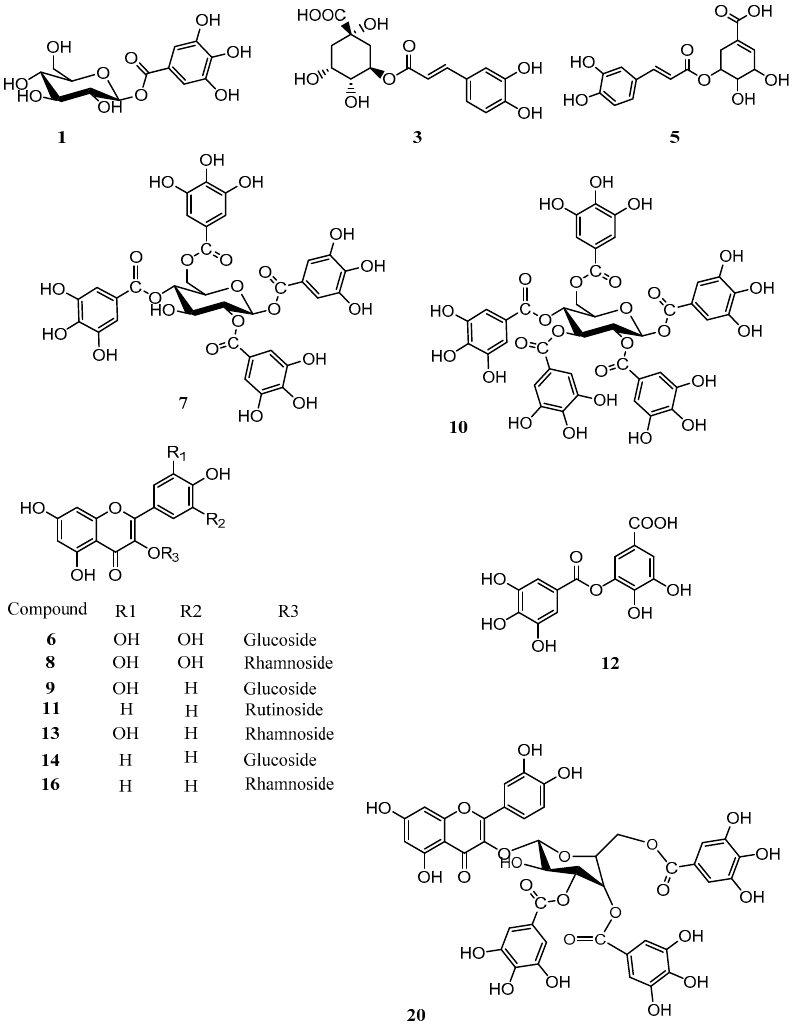
Figure 2. Structures of isolated compounds. Numbering is according to the chromatographic retention time.